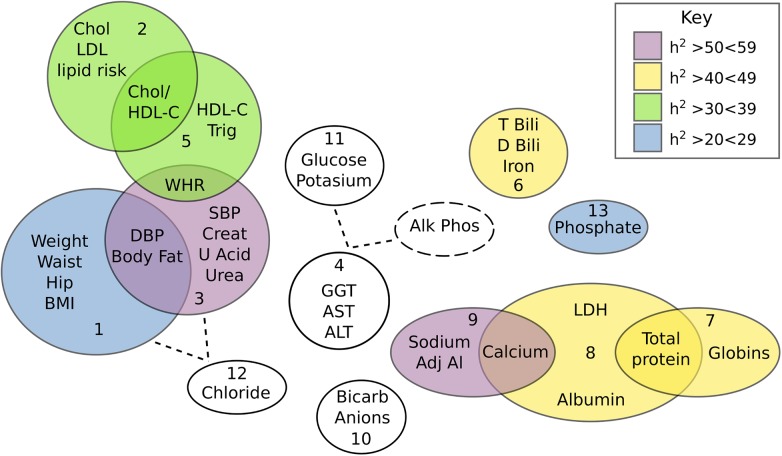
Venn diagram showing the inter-correlation and heritabilities of components extracted from the PCA of 37 quantitative traits.Relationships between components were inferred either by variable overlap, or loadings on a component greater than 0.35. Heritability of each component is colour coded (as per key) with the non-significant traits being coloured white.